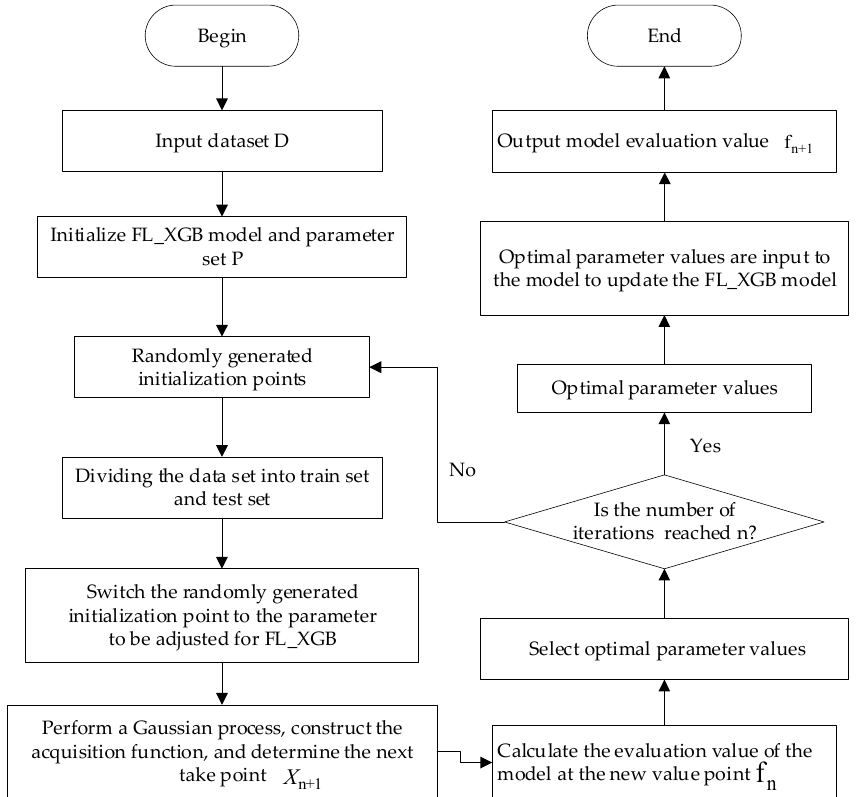
Figure 5. Optimization algorithm framework for encrypted traffic identification model.